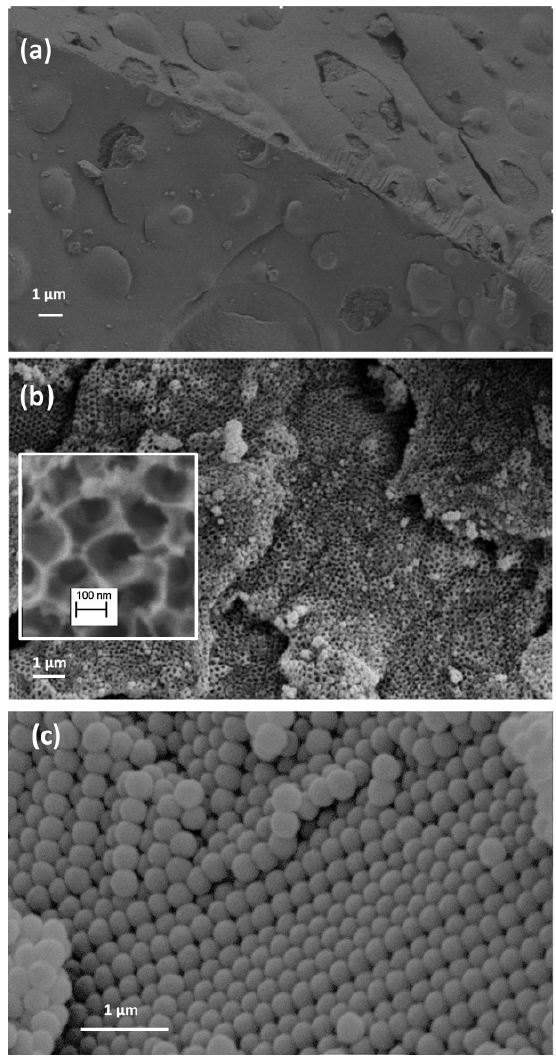
Figure 5. SEM images of ( a ) catalyst Ce ‐ Pr ‐ ref, ( b ) catalyst Ce ‐ Pr ‐ 3DOM, and ( c ) PMMA colloidal crystal template.